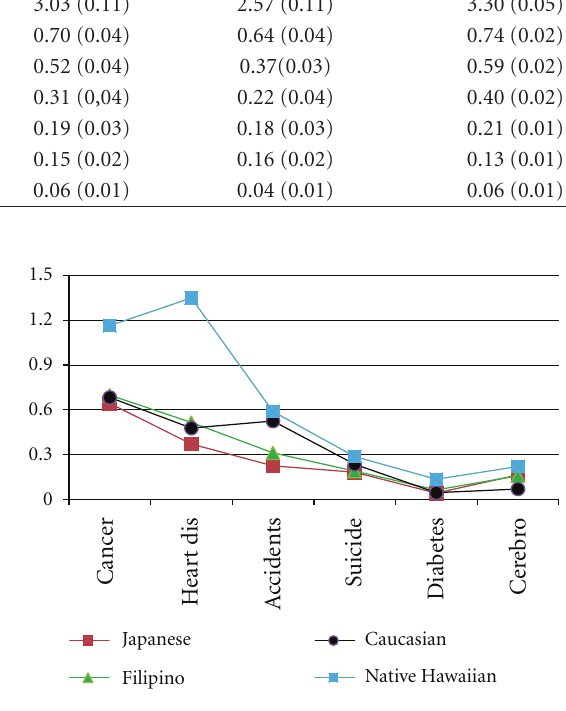
Figure 2: Total years of potential life loss by ethnic group and disease,